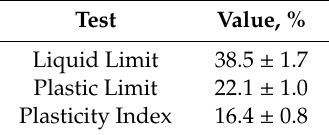
Table 2. Liquid limit, plastic limit and plasticity index for the clay used.